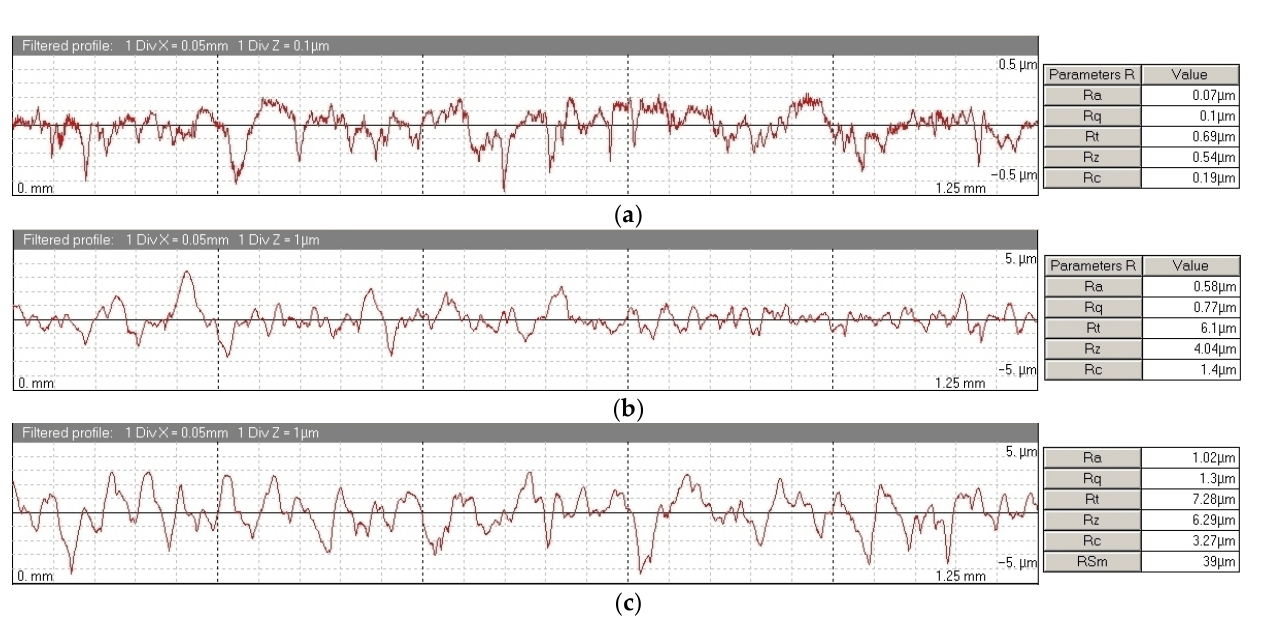
Figure 10. An example of the roughness profile (cutoff length = 0.25 mm) and the measured parameters of a Ø25 mm sphere: ( a ) original, ( b ) post-sandblasting, and ( c ) post-acid treatment.